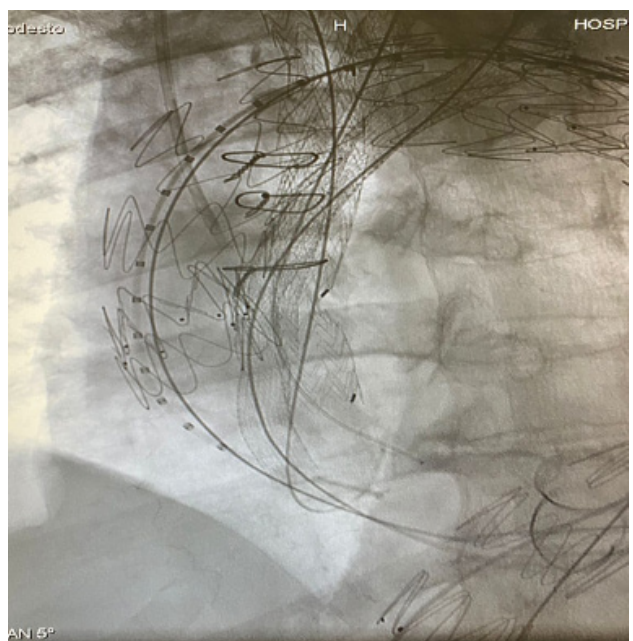
Fig. 4 - Final result showing all the endoprostheses